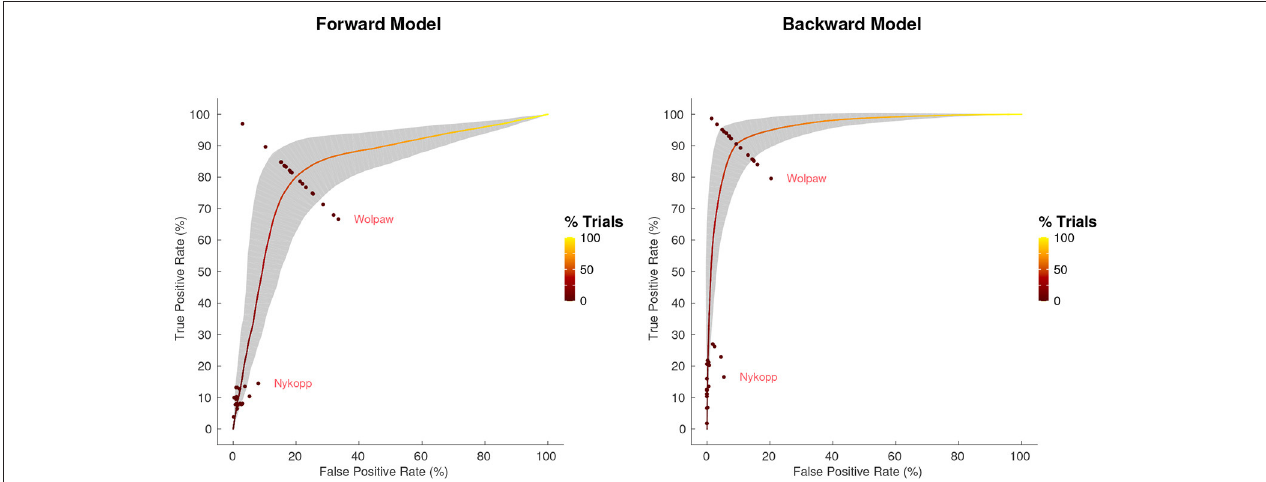
FIGURE 5 | Average receiver operating characteristic curve, with standard deviation band, for 30 s decoding segments using Tikhonov regularization. Points at which Wolpaw and Nykopp information transfer rates were evaluated for each subject are shown. Color along curve indicates percentage of decoding segment trials evaluated to obtain each point. The gray band indicates the standard deviation boundaries of the curve in both x and y